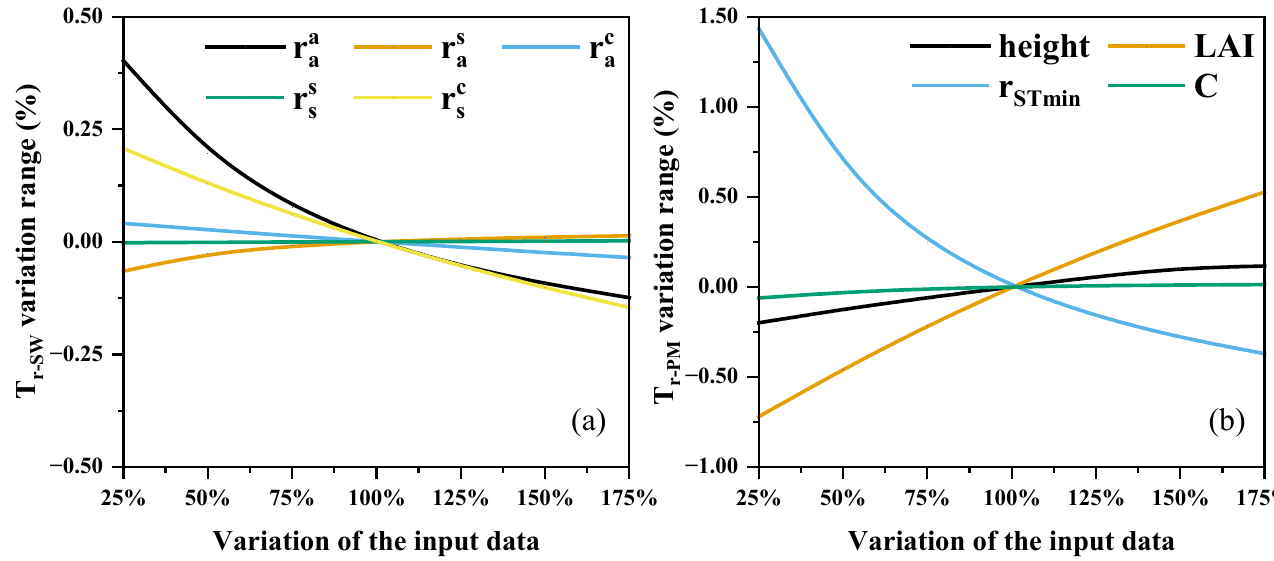
Figure 9. Sensitivity Analysis of SW ( a ) and PM ( b ) Models.